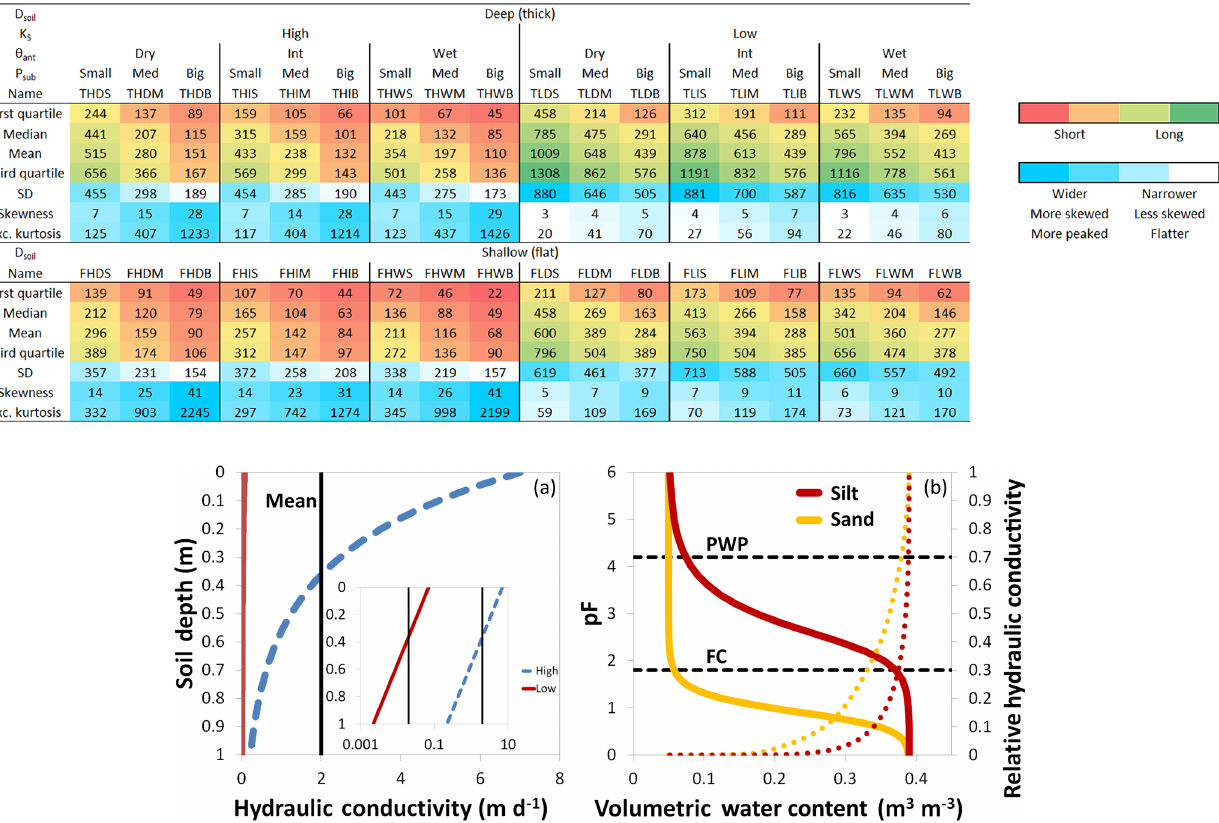
Figure 4. (a) Exponential decay in saturated soil hydraulic conductivity with depth for the high (blue) and the low (red) K S scenario. The x axis in the inset has a log scale. The spatial mean K S is indicated by the vertical black lines. (b) Water retention curves (solid) and relative hydraulic conductivities (dotted) for sandy and silty soils. The permanent wilting point (PWP) and the field capacity (FC) are marked as references